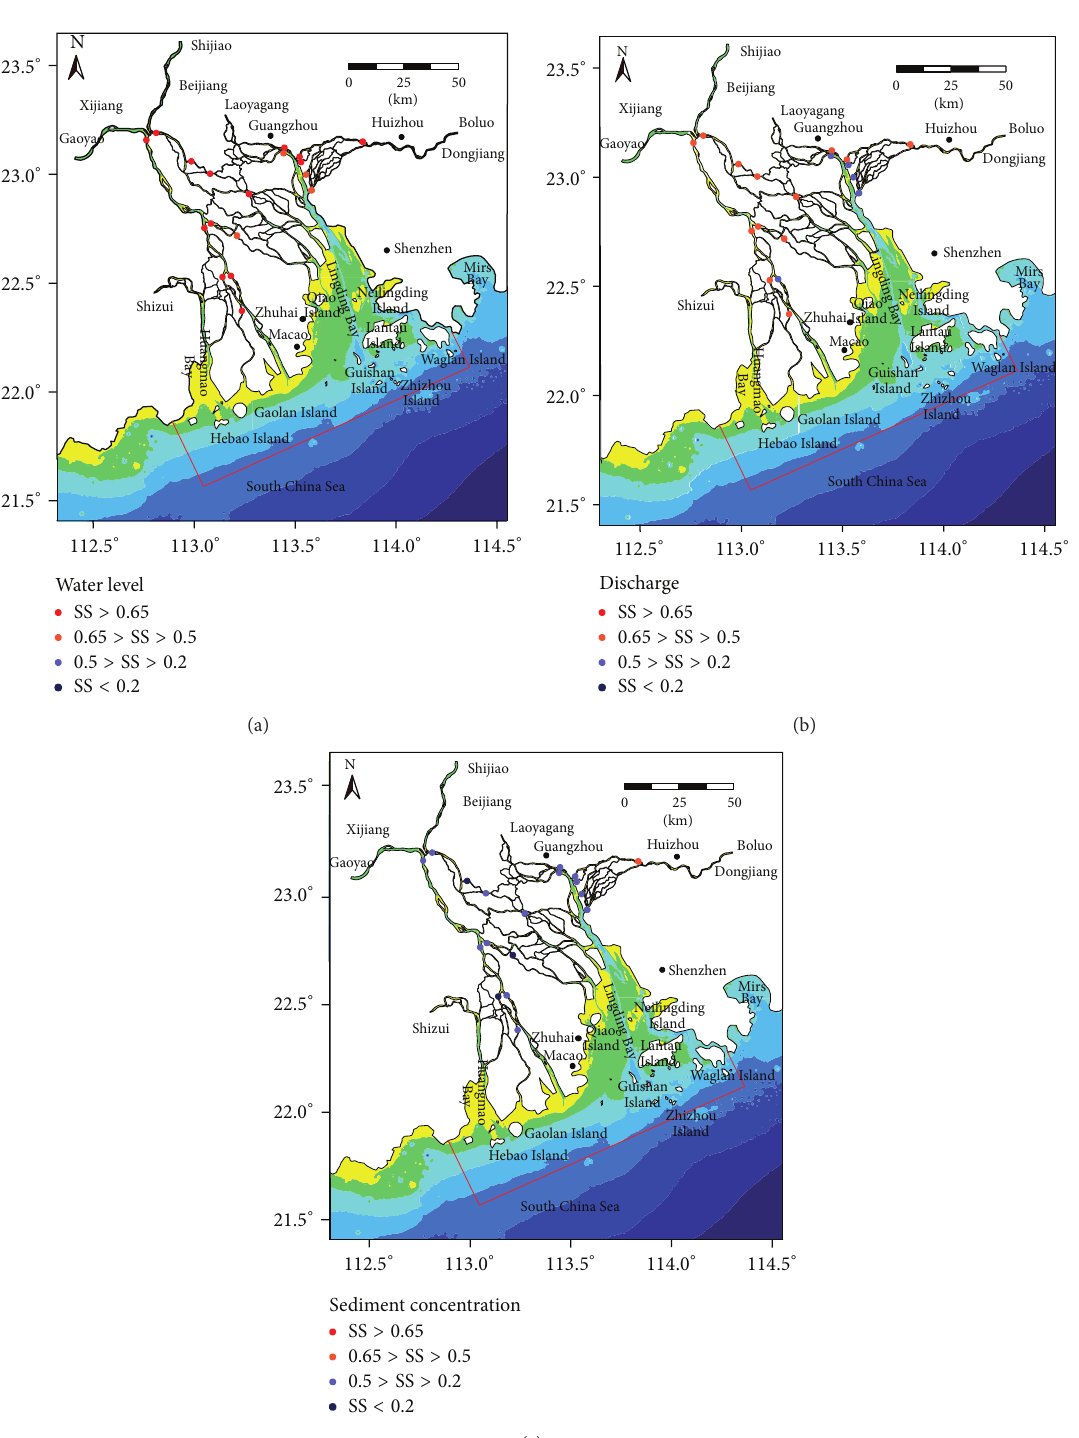
Figure 4: The calibration of the coupled model results with the measured time series at eighteen stations is shown, from December 19, 1998, to December 20, 1998 (dry season). The model skill score is used to evaluate the model performance of water levels (a), discharges (b), and suspended sediment concentration (c) quantitatively. The circles with the different colors represent the different performances of the model. With the high scores of the water levels and the discharges, the performances indicate the success of the model. The skill scores of the suspended sediment concentration are also good